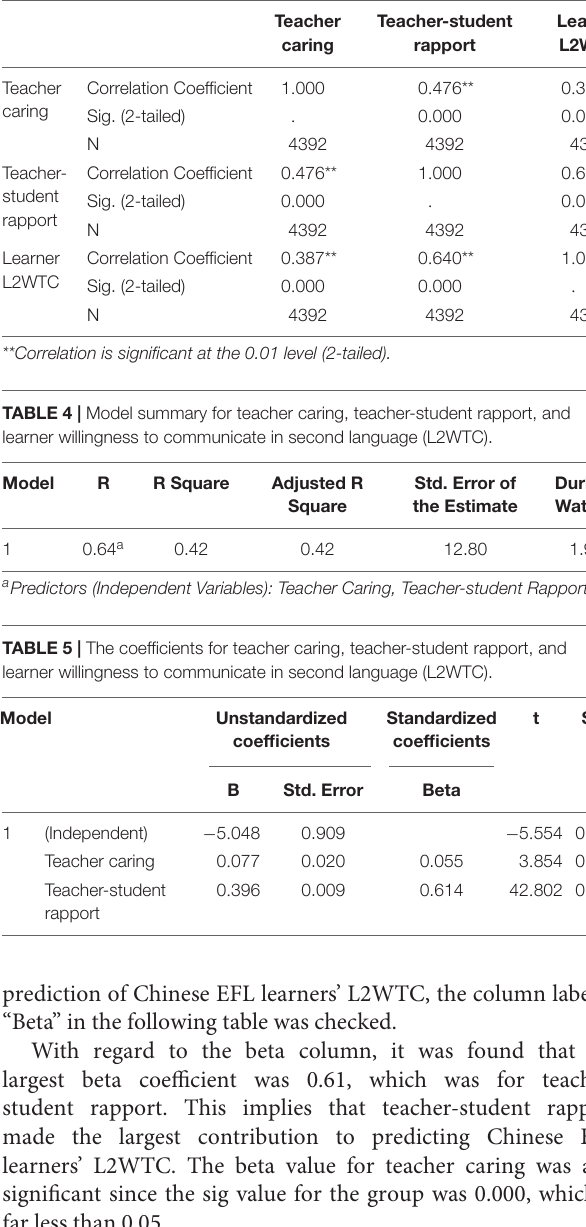
TABLE 3 | The results of Spearman Rho correlation between teacher caring, teacher student rapport, and learner willingness to communicate in second language